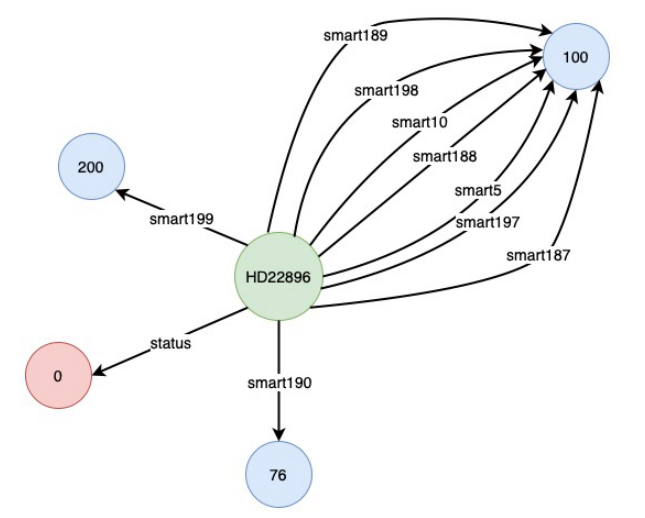
Figure 4. KG stored in CSV.